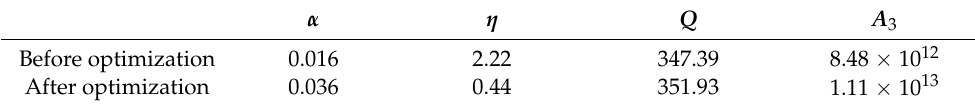
Figure 10. Comparison of the predicted stress with the experimental data at ε = 0.1 before (dotted lines) and after (solid lines) optimization. Table 9. The optimized material constants for the constitutive model.